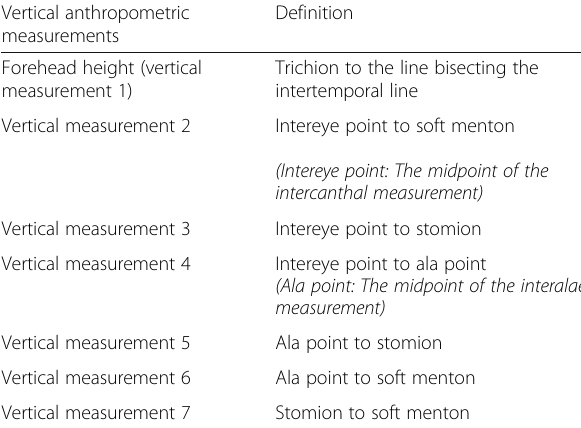
Table 3 Definitions of vertical facial measurements (see Fig. 1b)